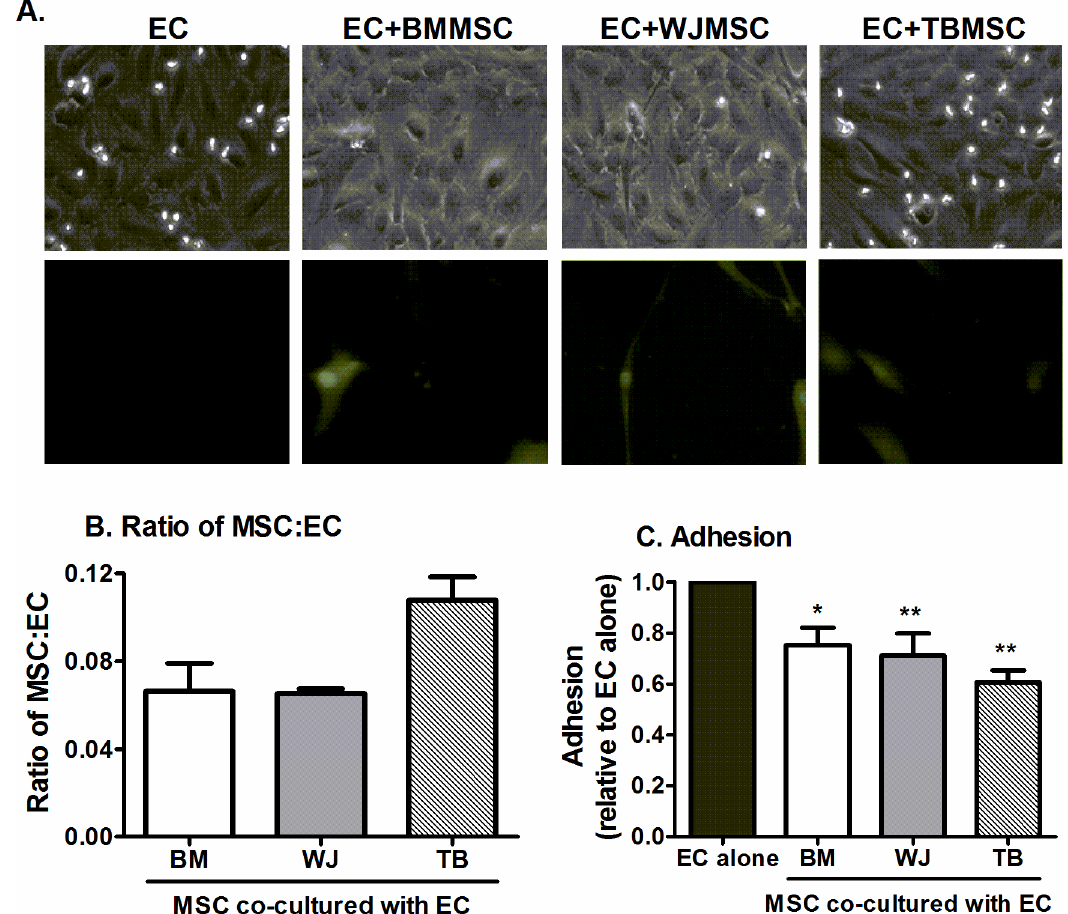
Fig 2. Effect of MSC from different tissues on neutrophil recruitment when cultured in direct contact with EC. BMMSC, WJMSC, or TBMSC were cultured in direct contact with EC in channel slides for 24h before addition of 100U/ml TNF α for 4h. (A) MSC labelled with Cell Tracker Green integrated into the EC monolayer. Fluorescent micrographs are representative of n = 3 independent experiments using 3 different MSC donors. (B) Ratio of MSC to EC for each co- culture assessed after the adhesion assay. ANOVA showed a significant effect of MSC source on MSC:EC ratio, p < 0.05; n = 3 independent experiments, using 3 different MSC donors for each MSC type. (C) Neutrophil adhesion expressed as a proportion of that observed on the paired EC mono-culture control. ANOVA showed a significant effect of culture conditions on adhesion, p < 0.01; n = 5 independent experiments, using 3 different BMMSC, 5 WJMSC and 5 TBMSC donors. Data are mean ± SEM, incorporating a different EC and neutrophil donor in each experiment. * = p < 0.05 and ** = p < 0.01 compared to EC mono-cultures a by Dunnett